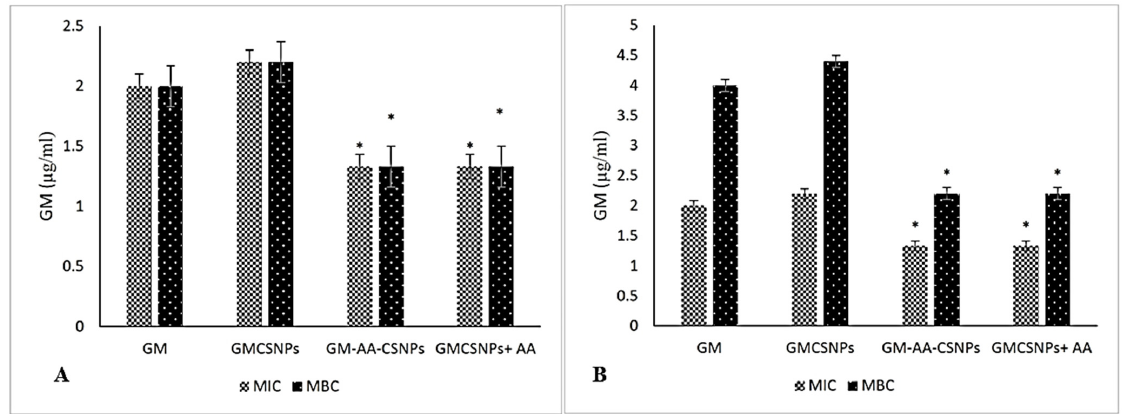
Figure 5. MICs and MBCs of free and loaded drugs for S. aureus ( A ) and P. aeruginosa ( B ). (*) represents the significant difference at p < 0.05 from the control and GM group.